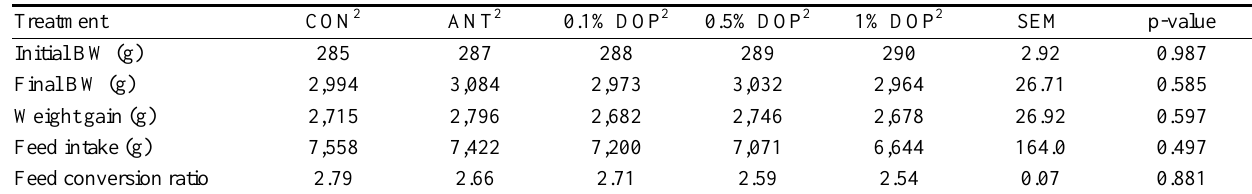
Table 5. Effect of dietary dried oregano powder (DOP) supplementation on growth performance in meat ducks 1